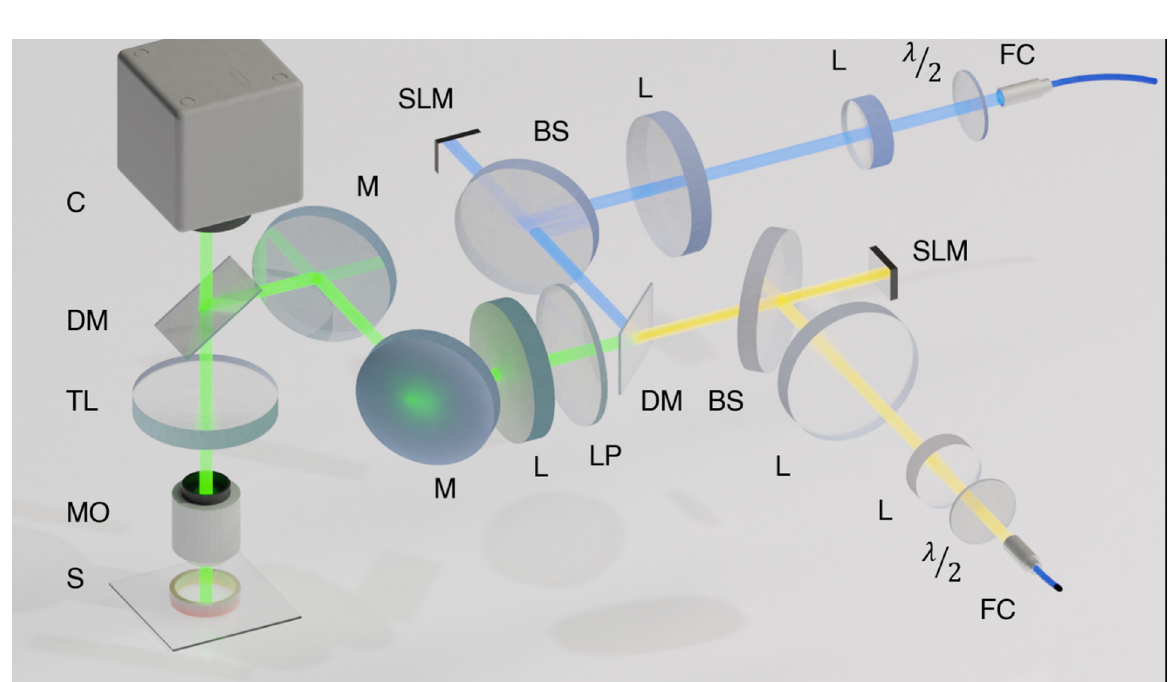
Figure 1. Schematic of the two-wavelength holographic optogenetic illumination platform. It consists of two similar holographic light projection paths marked in blue and yellow, one with a wavelength tuned to activating opsins (488 nm) and one for inhibiting opsins (589 nm). Each path consists of a solid-state laser source, beam-conditioning lenses and a fast ferroelectric spatial light modulator for wavefront shaping, pattern generation and temporal modulation. The shaped beams of the two paths are collinearly superposed by a dichroic mirror (beam path marked green), coupled into an inverted microscope and directed onto the cell sample. For further explanations, see text. FC—fiber coupler, λ /2—half-wave plate, L—lens, BS—non-polarizing beam splitter, SLM—ferroelectric liquid- crystal spatial light modulator, DM—dichroic mirror, LP—linear polarizer, M—mirror, TL—tube lens, MO—microscope objective, S—sample,